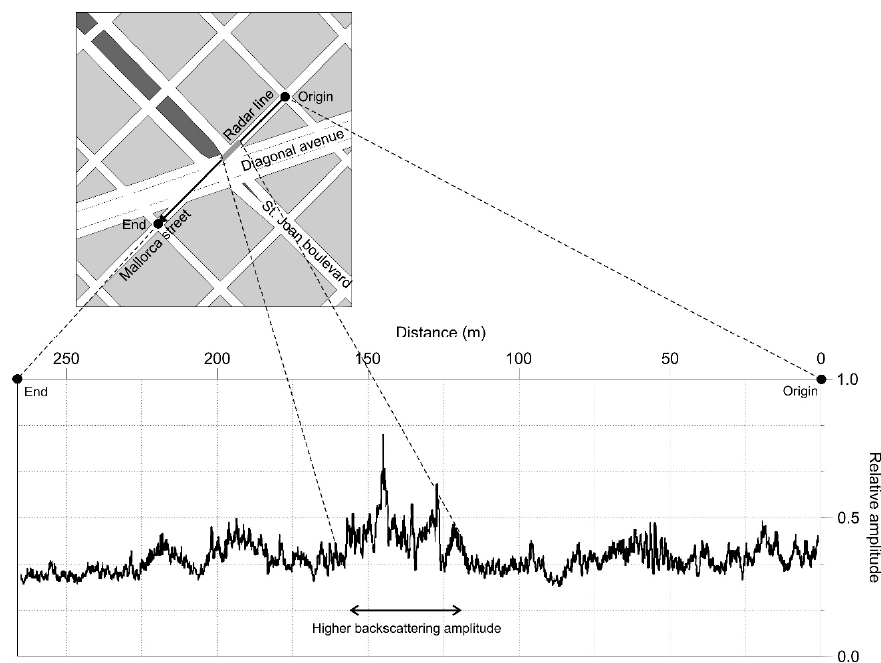
Figure 6. Average relative amplitude in the time-window versus the distance along the radar line and location of the profile at the city map.